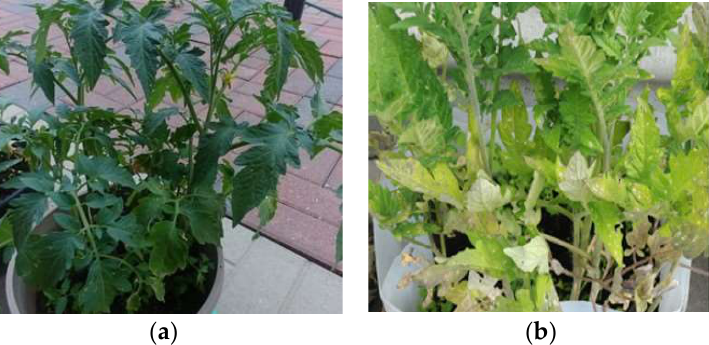
Figure 9. Tomato planting nursery pots substituted with and without HTC-PL residue. ( a ) With HTC-PL residue addition; ( b ) Without HTC-PL residue addition.